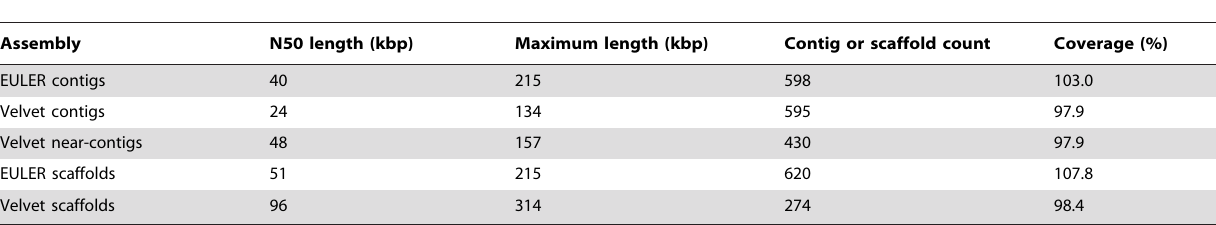
Table 1. Comparison of Velvet and EULER